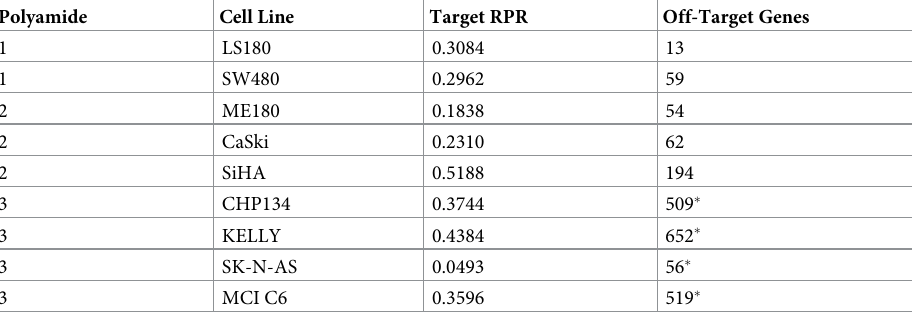
Table 1. Assessment of off-target binding of polyamides